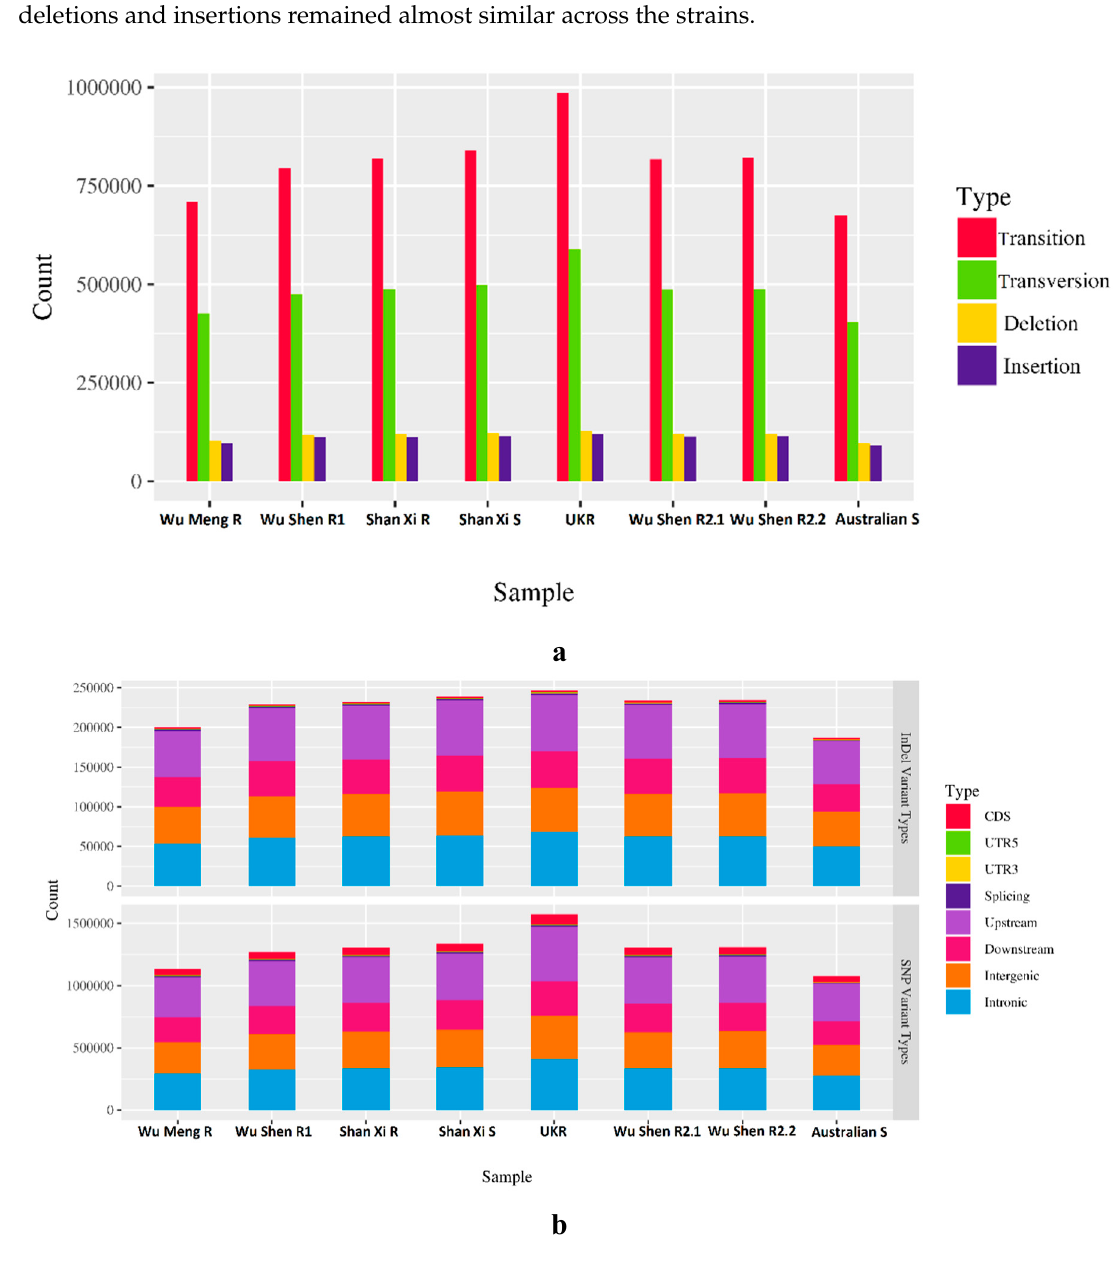
Figure 1. Summary of SNPs and InDel. ( a ) Total numbers of SNPs (transition + transversion) and InDel (deletion + insertion) in each population. ( b ) Distribution of SNPs (bottom panel) and InDel (top panel) across the genome.